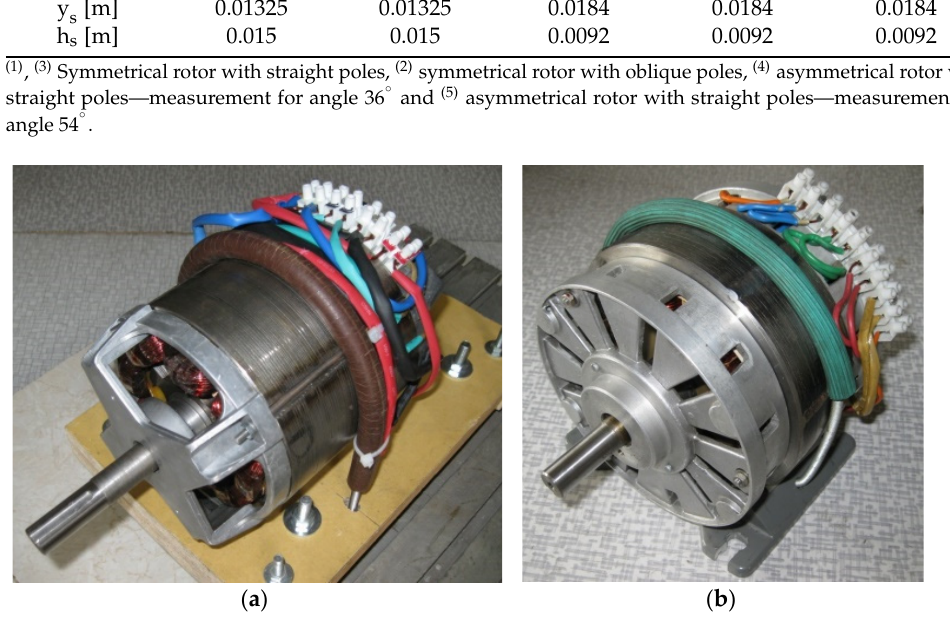
Figure 6. The appearance of the tested switched reluctance motors: ( a ) 8/6; ( b ) 10/8.